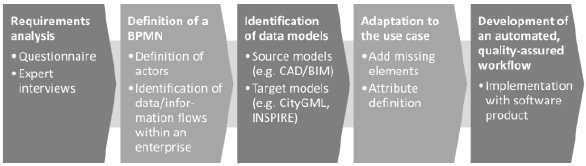
Figure 3. Workflow for the development of